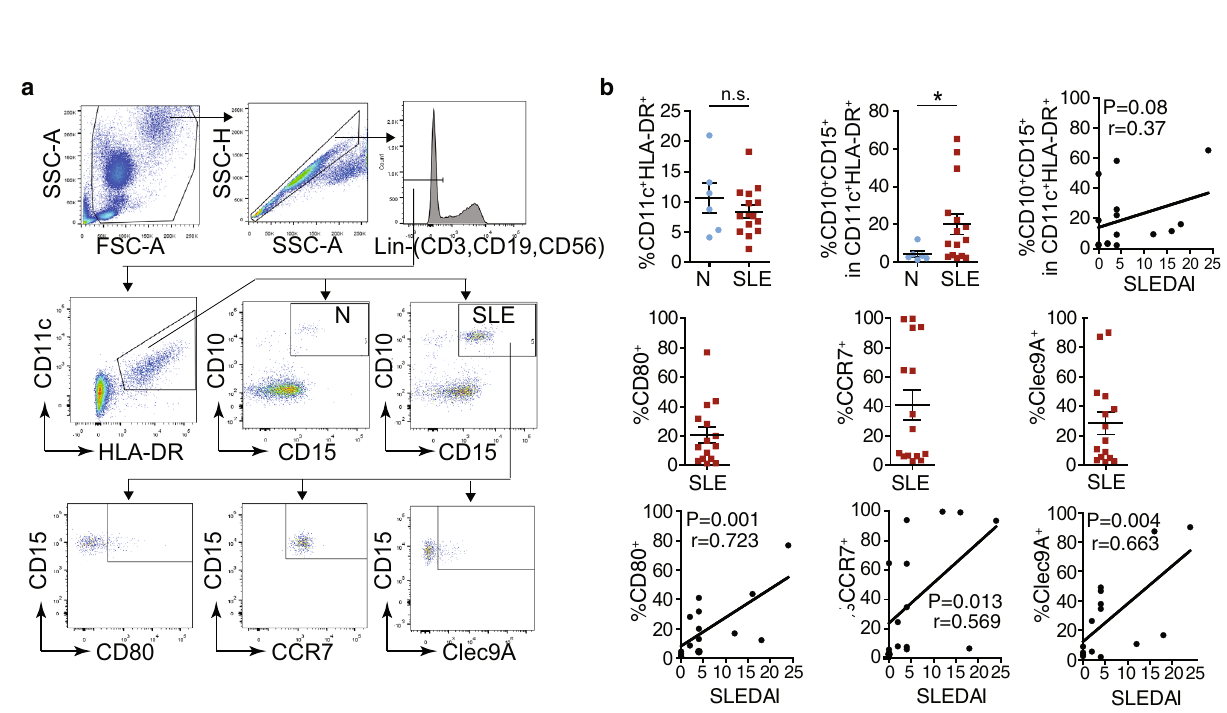
Fig. 2 The frequency of nAPCs in lupus blood correlates with disease scores. a , b Blood samples from normal human controls (N) and SLE patients were analyzed for CD11c and HLA-DR markers on lineage negative (Lin − ) cells. CD11c-HLA-DR positive cells were examined for neutrophil markers, CD10 and CD15. In SLE samples, CD10 and CD15 positive cells were further evaluated for CD80, CCR7, and Clec9A. Gating strategy for the samples is shown ( a ). The percent of neutrophils with indicated markers was determined and correlated with SLE disease activity index (SLEDAI) scores ( b ). Data are mean±s.e.m. Non-parametric test using Mann – Whitney analysis; correlation analyzed by a Spearman test. * p <0.05.